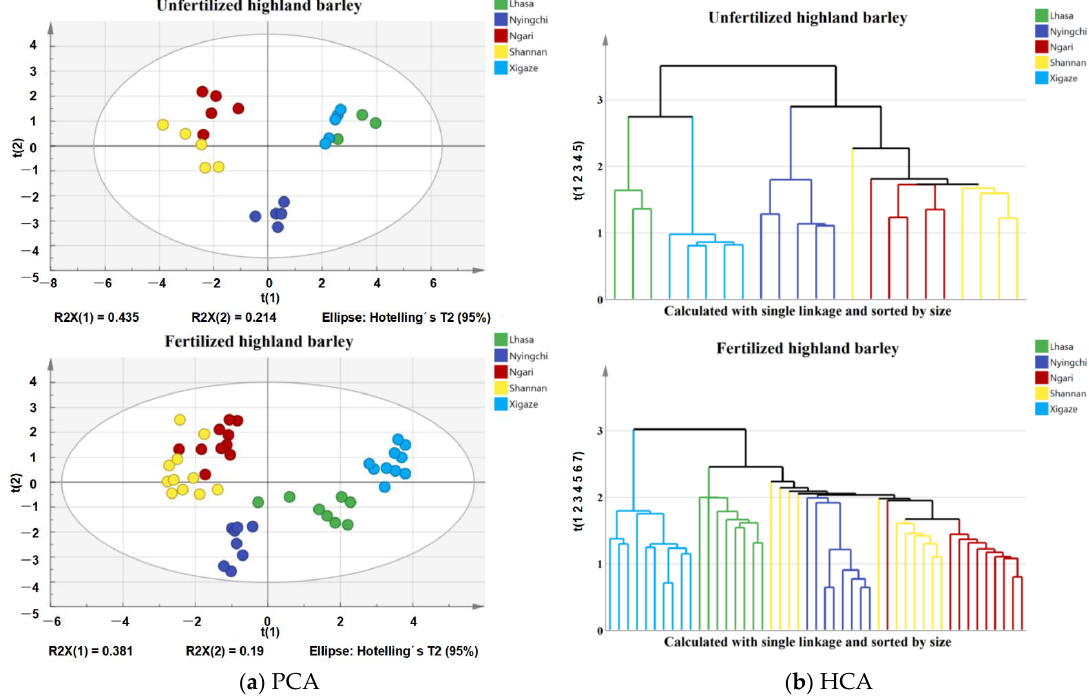
Figure 1. The PCA and HCA of fertilized and unfertilized highland barley samples from five regions of Tibet with data on nutrients and mineral elements: ( a ) PCA; ( b ) HCA. The VIP value (Figure 2) can quantify the contribution of each variable to the classi- fication. The larger the VIP value, the more significant the difference in the variable among different regions of highland barley [37]. For the unfertilized highland barley, seven vari- ables (P, crude fiber, Fe, Cu, K, crude protein, and β -glucan) have higher importance val- ues (>1). For the fertilized highland barley, only five variables (P, Fe, K, Ca, and Cu) have higher importance values (>1). This may be a result of the fact that the differences in the nutrient and mineral element contents in highland barley from different areas become larger after fertilization. Fewer indicators can distinguish highland barley samples from different areas. Common variables included P, K, Fe, and Cu. These indicators were highly correlated with the producing area of highland barley and can provide certain theoretical support for the traceability of the producing area of highland barley.